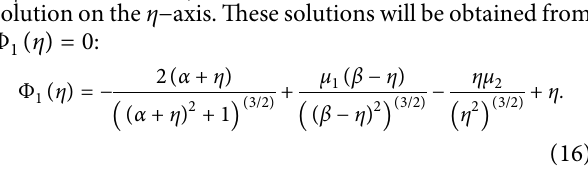
when μ � 1 (a) C � − 4 . 4, (b) C � − 4 . 9, (c) C � − 5